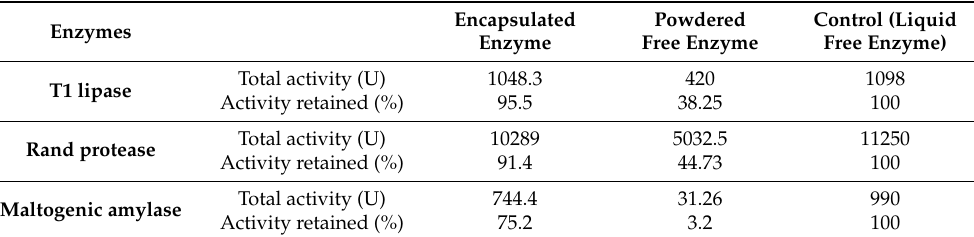
Table 2. Enzymatic activity performance of encapsulated enzymes.